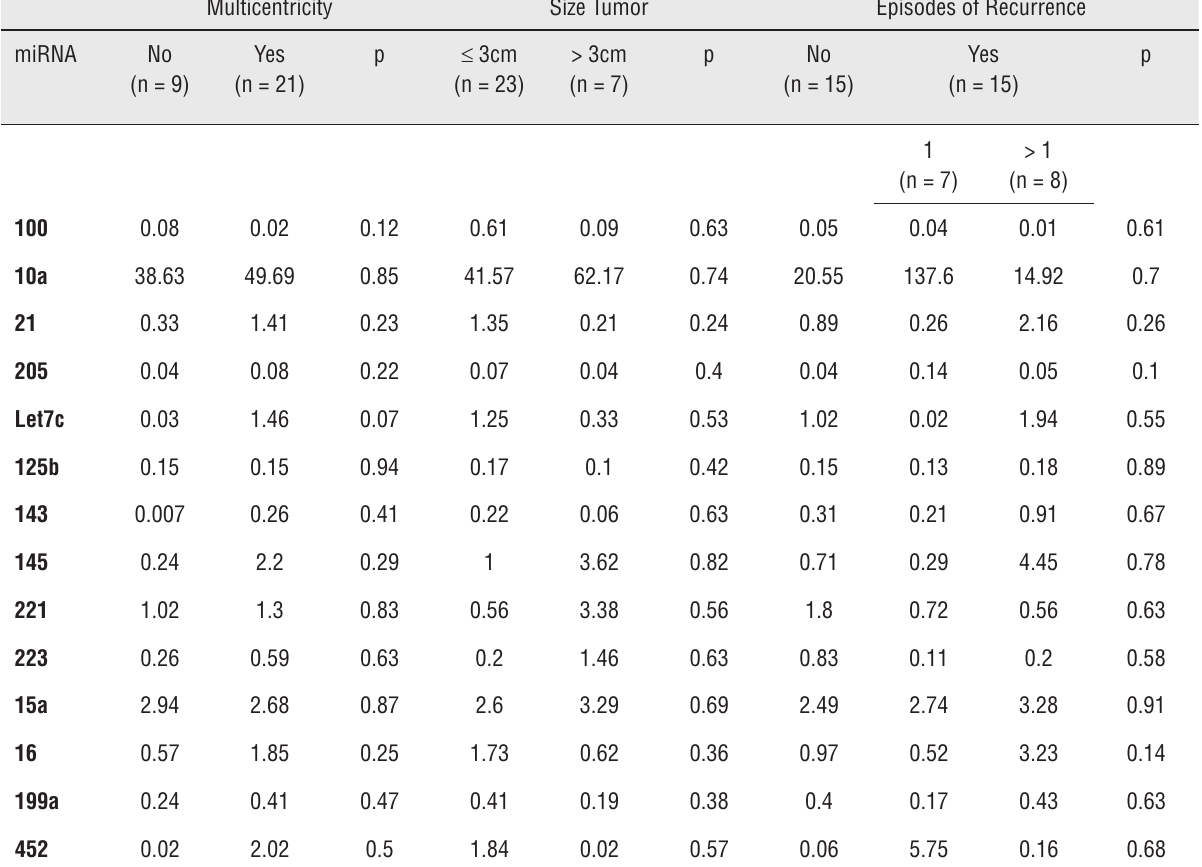
Table 2 - Means of expression of the 14 miRNAs considering the prognostic factors studied in 30 low-grade non-invasive pTa samples. The values listed are presented in fold-change compared to